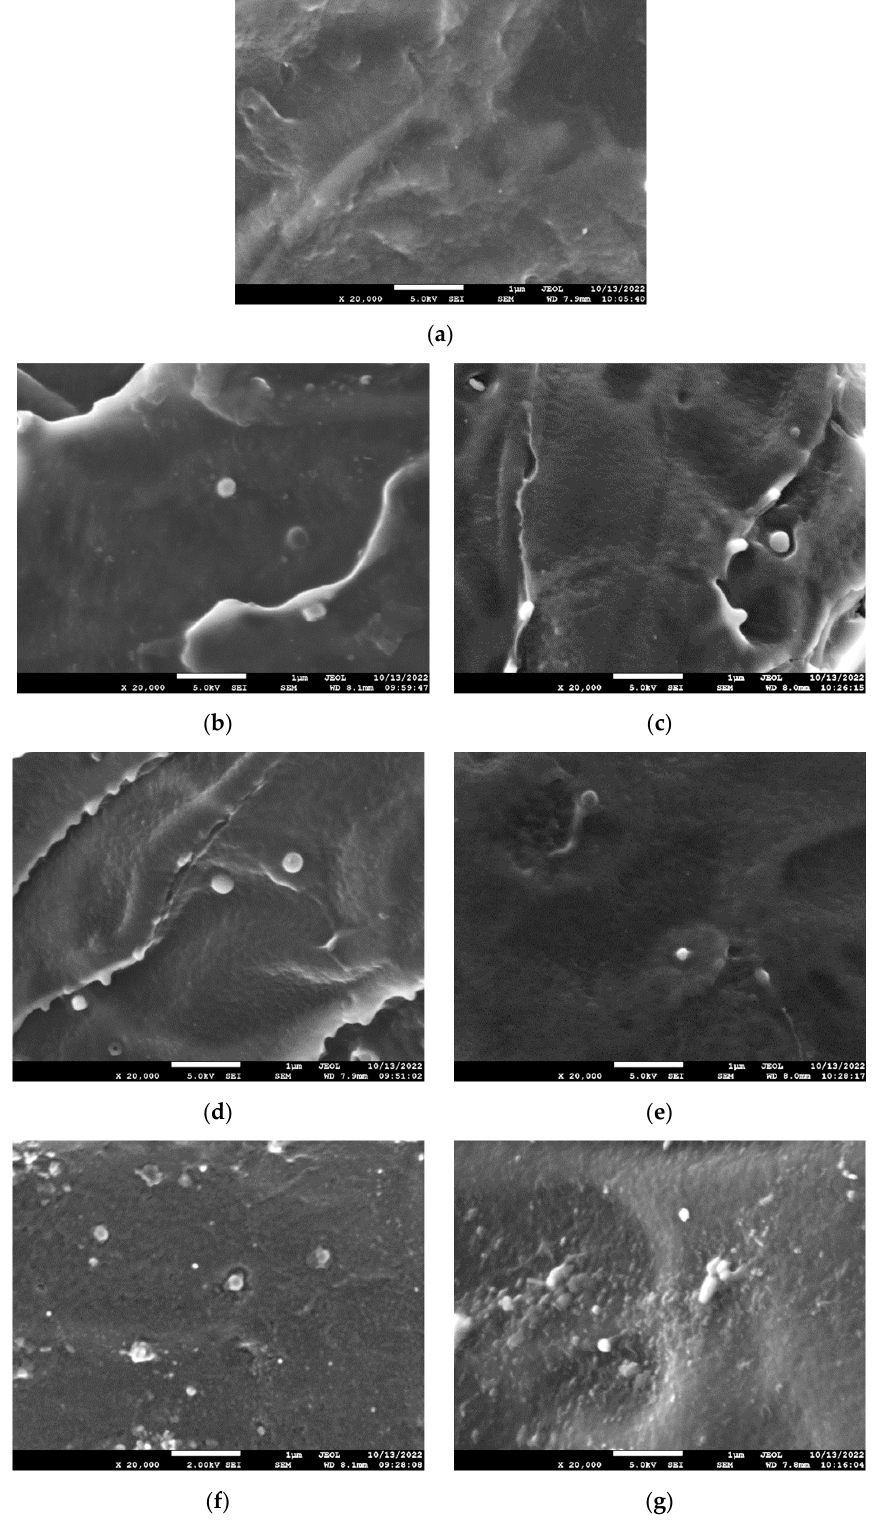
Figure 3. SEM micrographs of cryo-fractures cross-sections of PLA and its composites with OBS and OBSBM8 lignin. Magnification × 20,000. ( a ) PLA neat, ( b ) PLA + 0.5% OBS, ( c ) PLA + 0.5% OBSBM8, ( d ) PLA + 1% OBS, ( e ) PLA + 1% OBSBM8, ( f ) PLA + 2.5% OBS, ( g ) PLA + 2.5%